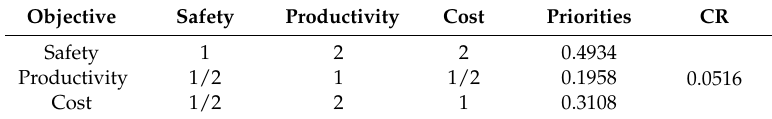
Table 2. Pairwise comparisons of objectives with respect to the objective criterion.